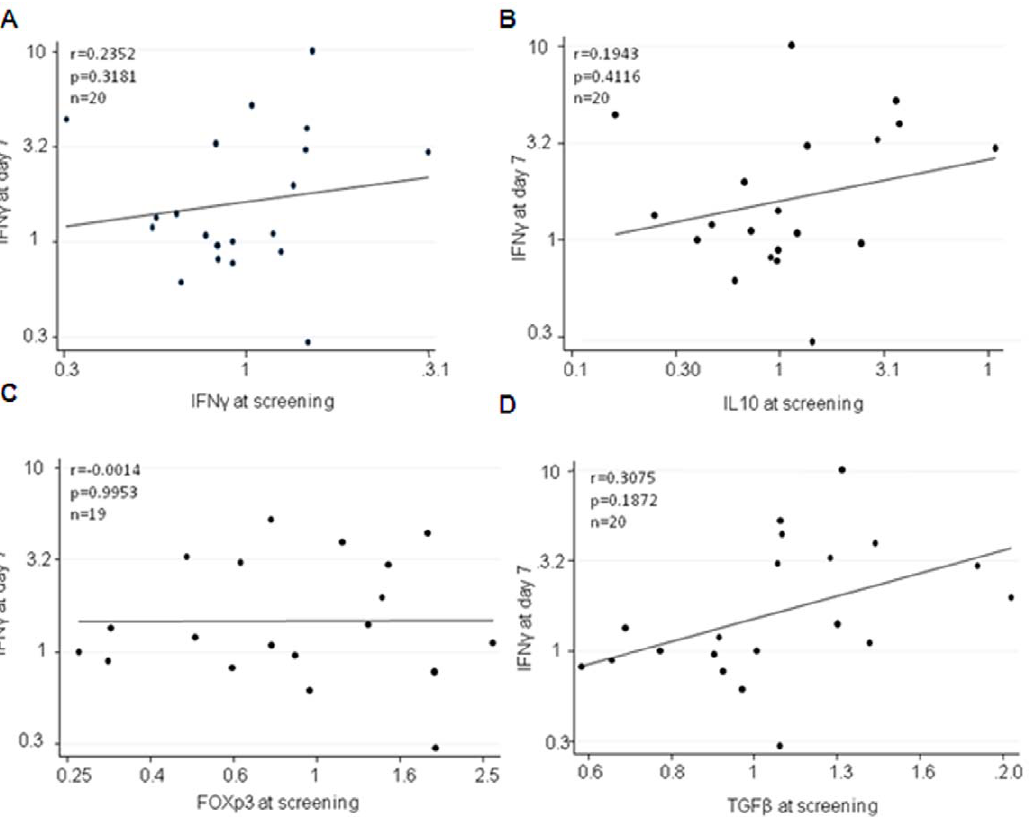
Figure 2. Correlation between IFN- c mRNA 1 week following vaccination and baseline IL10, FoxP3 and TGF- b 1 mRNA. There was no correlation between antigen specific IFN- c and A) IFN- c at screening B) IL10 at screening C) FoxP3 at screening D) TGFB at screening